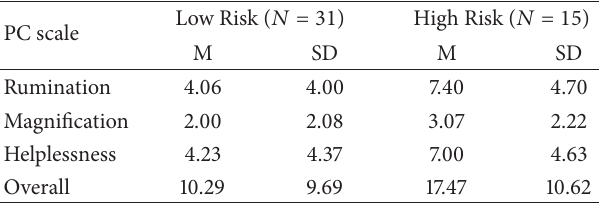
Table 4: Means (M) and standard deviations (SD) for risk of postconcussion syndrome development in relation to pain catastro- phizing